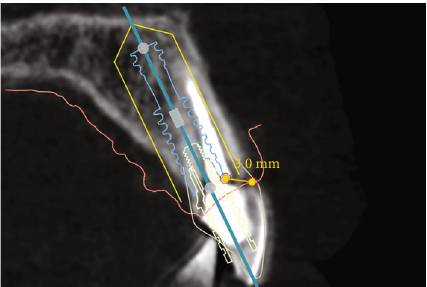
Figure 3: Sagittal view of the CBCT scan showing the prosthetically and biologically driven implant planning.